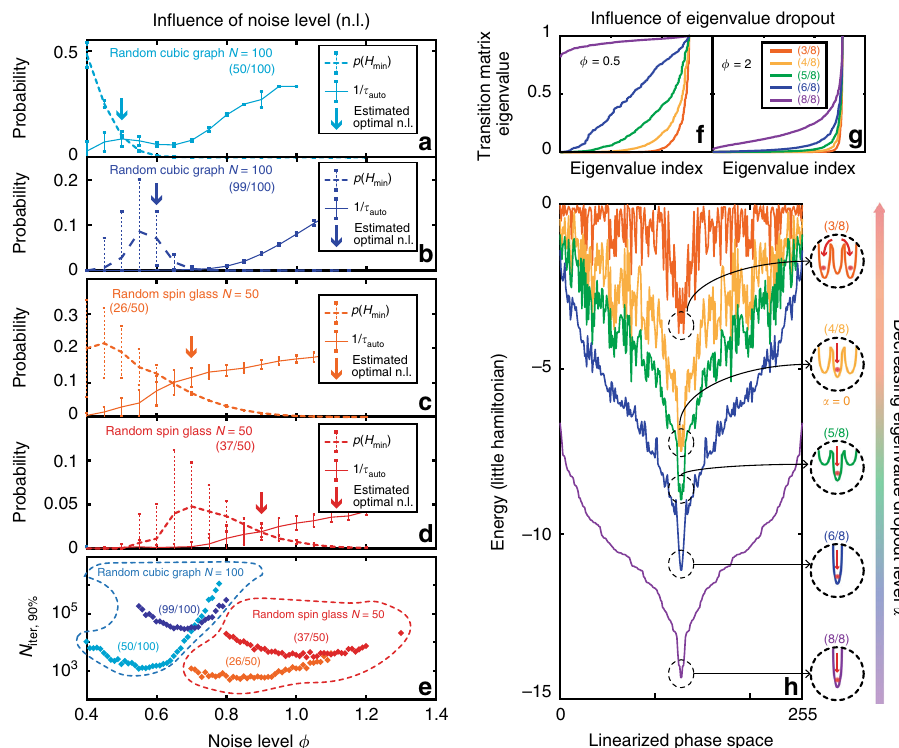
Fig. 3 In fl uence of noise and eigenvalue dropout levels. a – d Probability of fi nding the ground state, and the inverse of the autocorrelation time as a function of noise level ϕ for a sample Random Cubic Graph 9 ( N = 00, (50/100) eigenvalues ( a ), (99/100) eigenvalues ( b ), and a sample spin glass ( N = 50, (37/100) eigenvalues ( c ), (26/100) eigenvalues ( d )). The arrows indicate the estimated optimal noise level, from Eq. (8), taking τ E this study we averaged the results of 100 runs of the PRIS with random initial states with error bars representing ± σ from the mean over the 100 runs. We assumed Δ ii = ∑ j K ij . ( e ): N iter, 90% versus noise level ϕ for these same graphs and eigenvalue dropout levels. f – g Eigenvalues of the transition matrix of a sample spin glass ( N = 8) at ϕ = 0.5 ( f ) and ϕ = 2 ( g ). h The corresponding energy is plotted for various eigenvalue dropout levels α , corresponding to less than N eigenvalues kept from the original matrix. The inset is a schematic of the relative position of the global minimum when α = 1 (with (8/8) eigenvalues) with respect to nearby local minima when α < 1. For this study we assumed Δ ii = ∑ j K ij